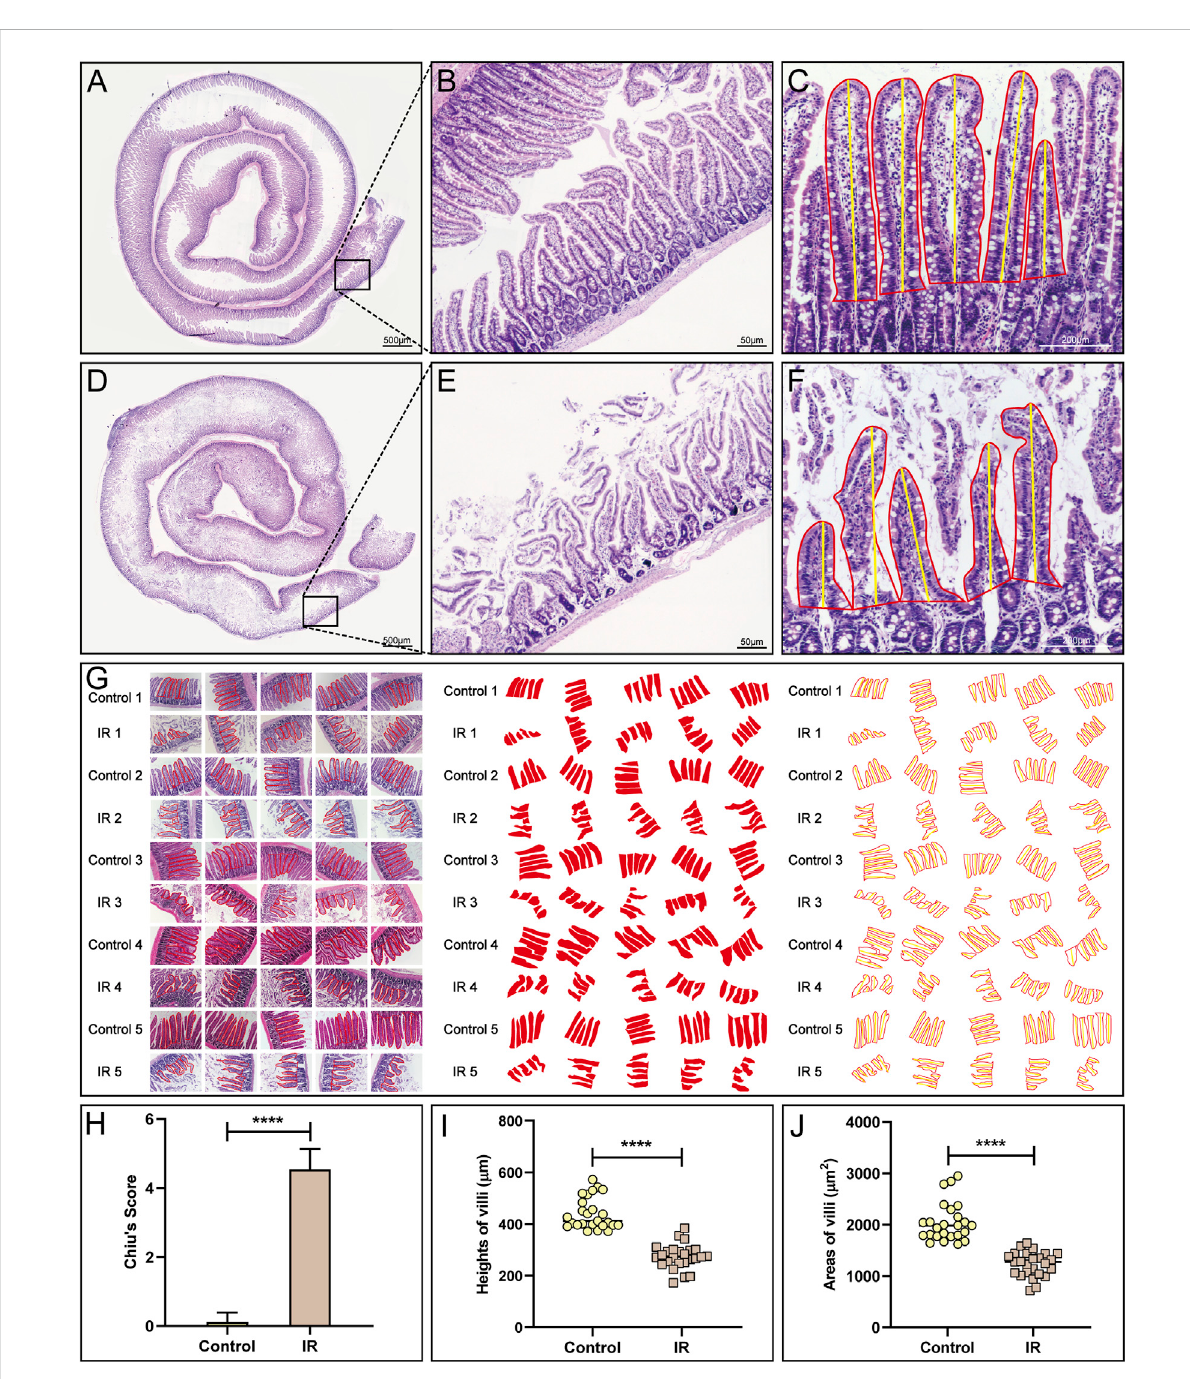
FIGURE 2 Pathological evaluation of the small intestinal IR injury model. (A,B) HE staining of the normal small intestine is shown. (D,E) HE staining of the modlledsmallintestineisshown. (C,F,G) Themethod (C,F) andprocess (G) usedtomeasurevillousheightandareainthecontrolandIRgroups. (H) A statistical comparison of the small intestinal Chiu ’ s score between the control and IR groups was performed ( n = 25). (I,J) A statistical comparison of the height and area of small intestinal villi between the control and IR groups was performed ( n = 25). Data are presented as the mean ± SD (**** p <